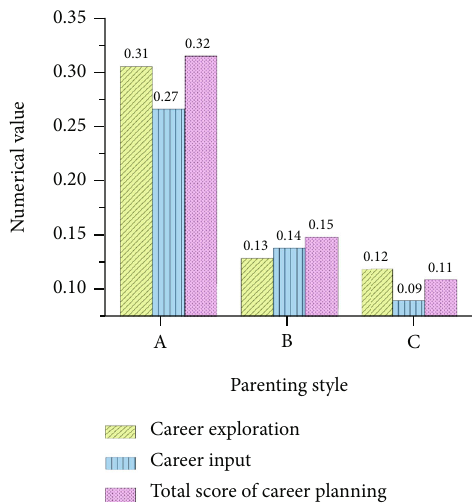
Figure 9: Correlation analysis between parenting style and